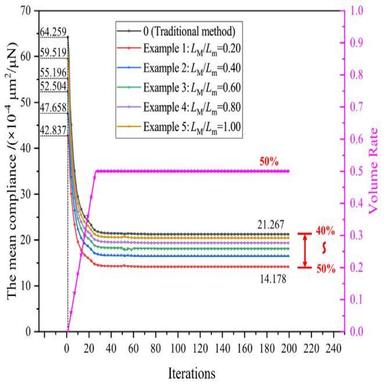
Optimization iteration history for the MBB beam with different Lm.